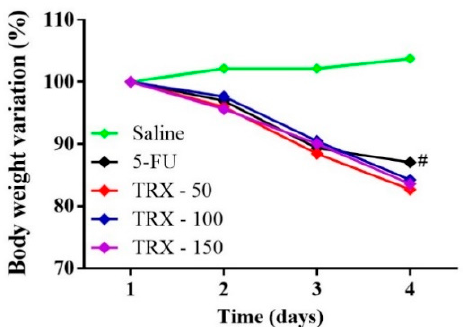
Figure 2. Body weight variation in mice subjected to induced intestinal mucositis (5-FU, 450 mg / kg, ip, single dose) and treated with TRX (50, 100, and 150 mg / kg for 3 days). The results are expressed as the mean ± SEM of the weight evaluation percentage of the initial weight, of a minimum of six animals per group. Two-way ANOVA followed by the Tukey’s test were used for the statistical analysis, where # p < 0.05 vs. saline and * p < 0.05 vs. 5-FU.